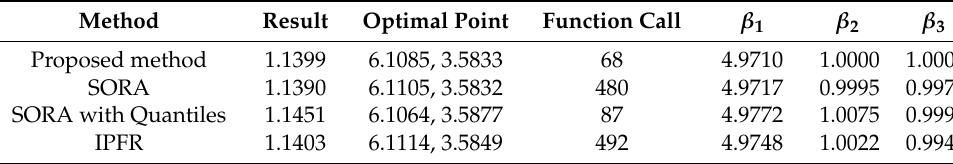
Table 4. Comparison results summary of the Choi